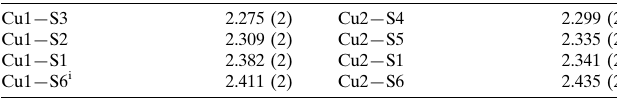
N S) ]I (cid:1) 0.5CH CN} , was formed n 4 2 3 3 Hydrogen-bond geometry (A˚ , (cid:4) ). D —H (cid:1)(cid:1)(cid:1)